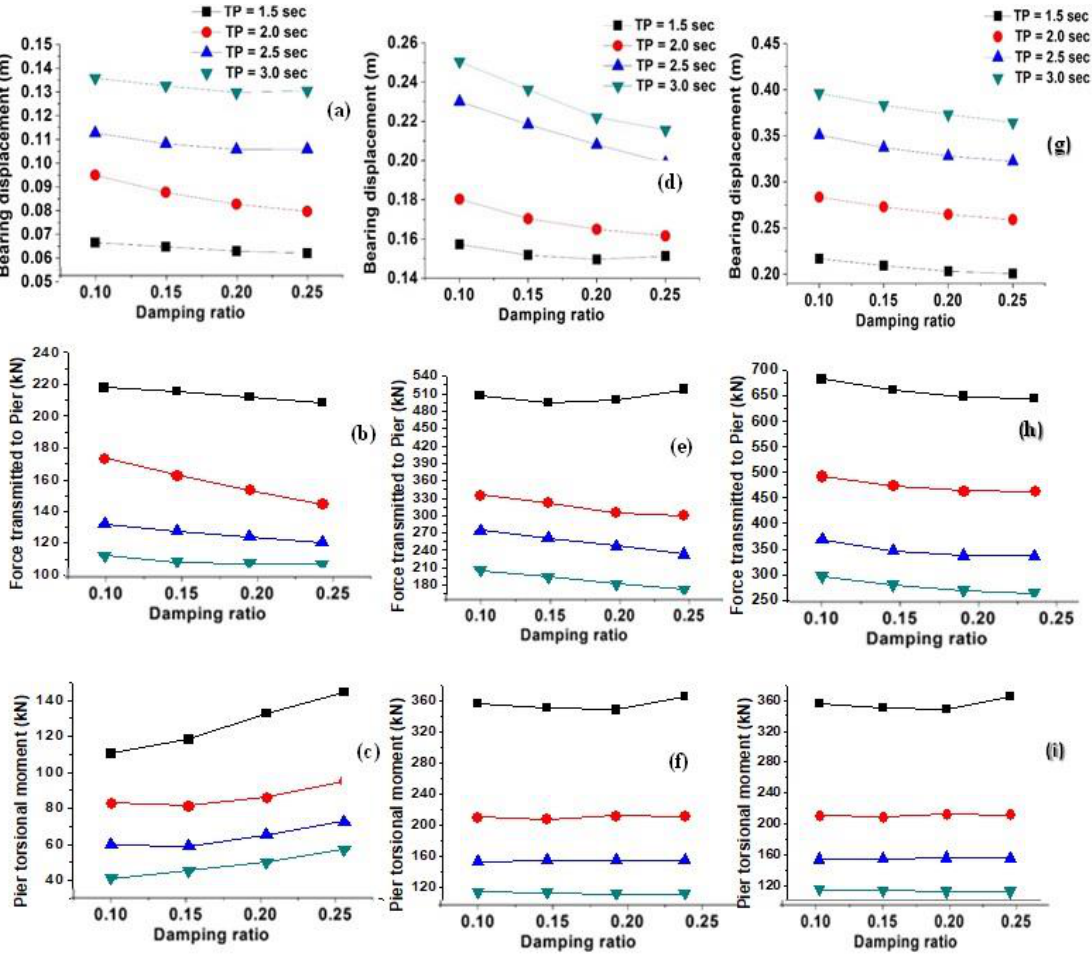
Figure 11. Response sensitivity of the isolated bridge with respect to damping ratio of LRB for bi-directional (i) Imperial Valley ( a – c ), (ii) Kobe ( d – f ), and (iii) Turkey ( g – i ) ground motions. The force transmitted is found to be decreased for every increase in the time period for all the ground motions. The maximum increase in force transmitted (about 69%) has been observed for Kobe ground motion, whereas, for Imperial Valley and Turkey ground motions, the maximum increase is 50% and 62%, respectively. Also, in Kobe and Turkey ground motions, the variations of force transmitted to the pier are found to be almost the same for all the considered damping ratios of the bearings. The variation of the pier tor- sional moment is non-linear and sensitive to all the ground motions. For Imperial Valley, Kobe, and Turkey ground motions, the pier torsional moment is decreased by about 63%, 72%, and 70%, respectively. However, the variations in pier torsional moment are nearly identical for all damping ratios for Kobe and Turkey ground motions.